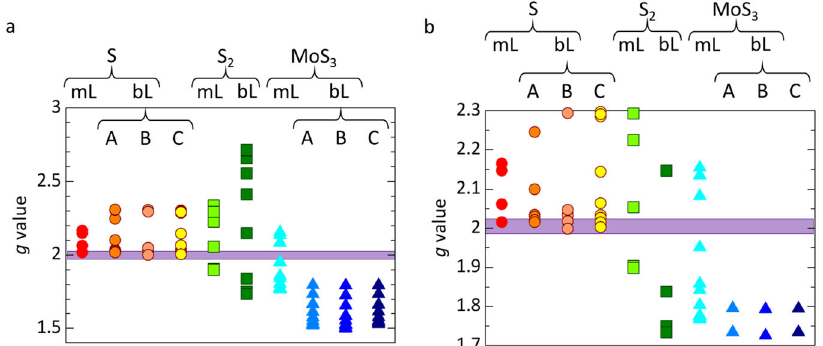
Fig. 6 Calculated g -factor for various atomic vacancies and charge doping. The g -factor calculated for the S, S 2 , and MoS 3 vacancies in the MoS 2 supercell of size 12 × 12 × 1 unit, with 1 – 12 injected electrons, are collectively displayed. Purple area indicates the range of the observed g -factors of Signal B ( g = 1.987 – 2.003). For the case of bilayer (bL), types A, B, and C are de fi ned depending on the arrangement of atomic vacancies (see